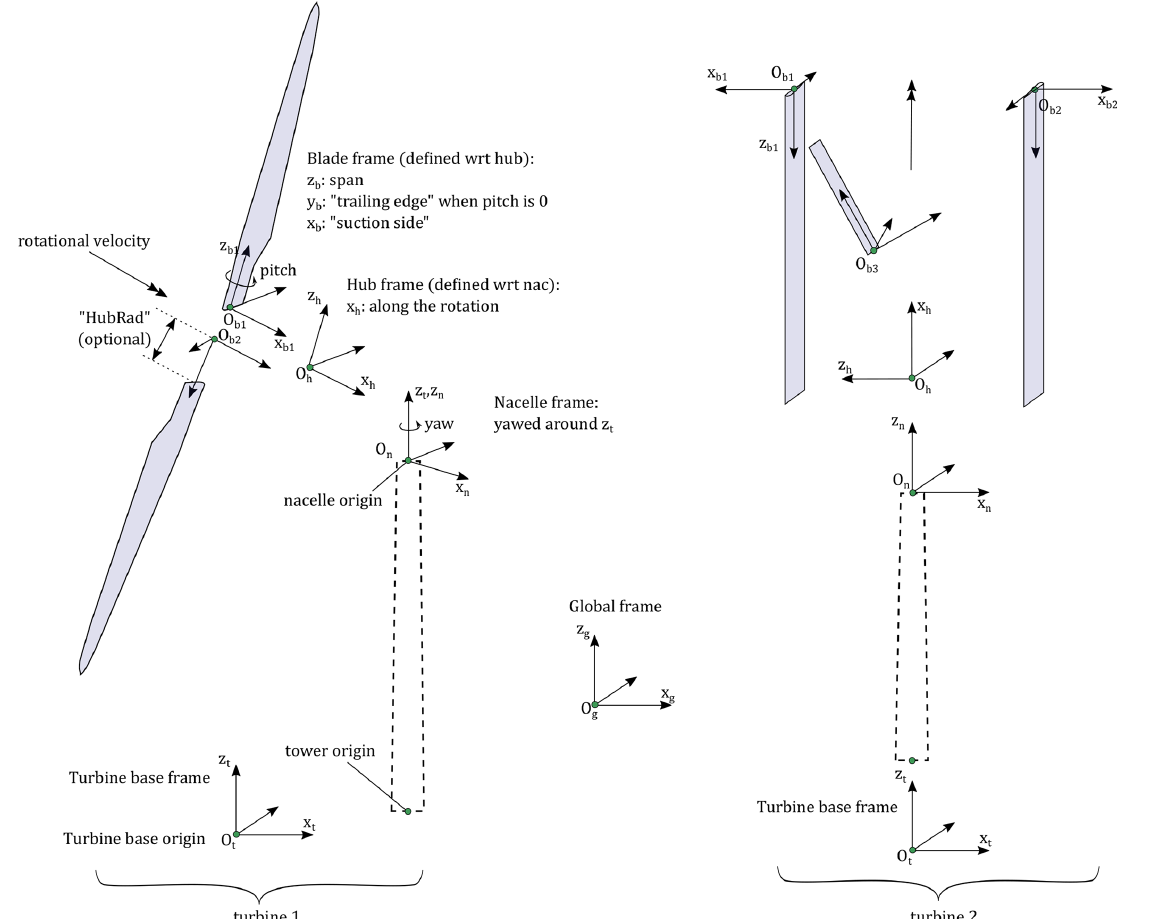
Figure 1. Definition of frames and origins for a two-turbine configuration – HAWT (left) and VAWT